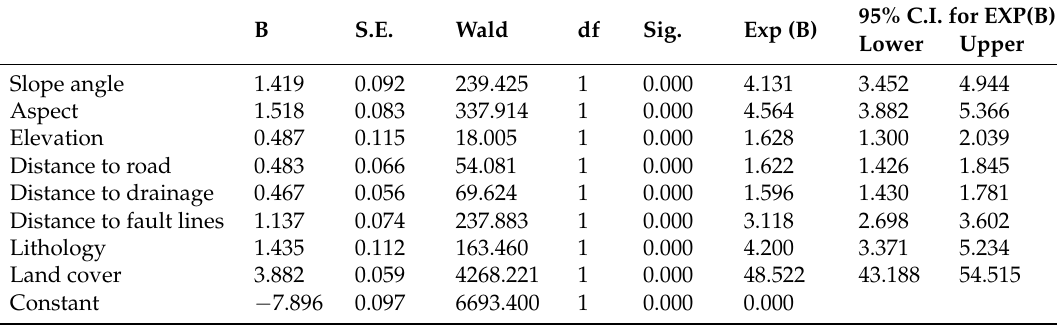
Table 4. Coefficients of each factor derived from logistic regression.